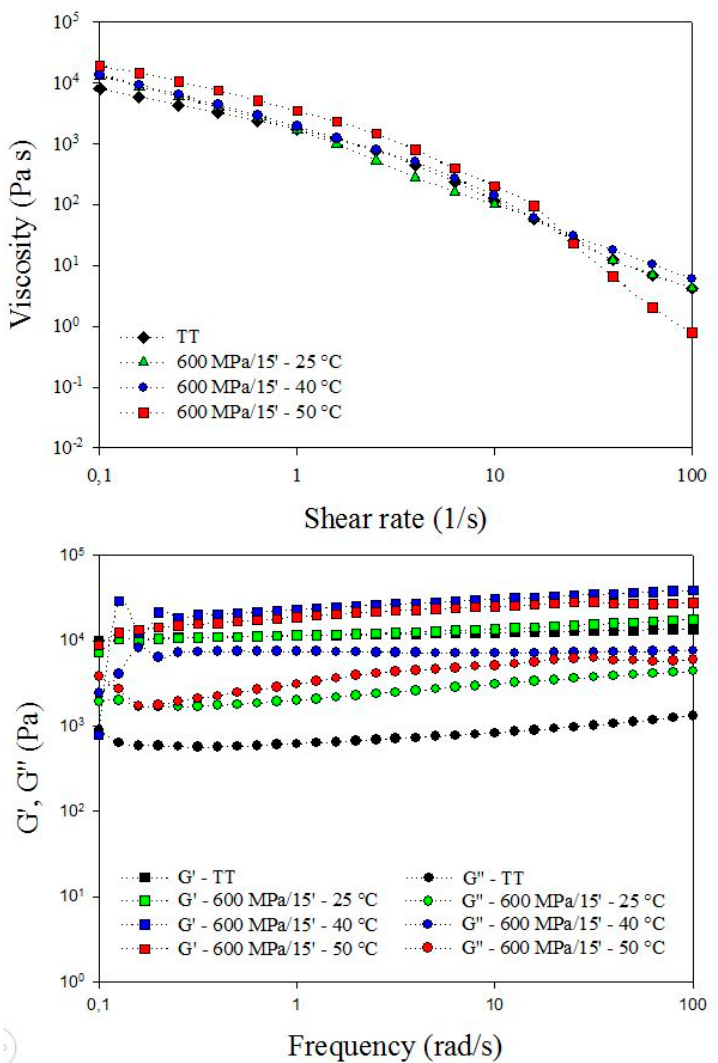
Figure 6. Rheology of potato starch suspension (25 µm, 20% w/w) subjected to thermal and high pressure treatments at 600 MPa for 15 min at 25 °C, 40 °C and 50 °C.